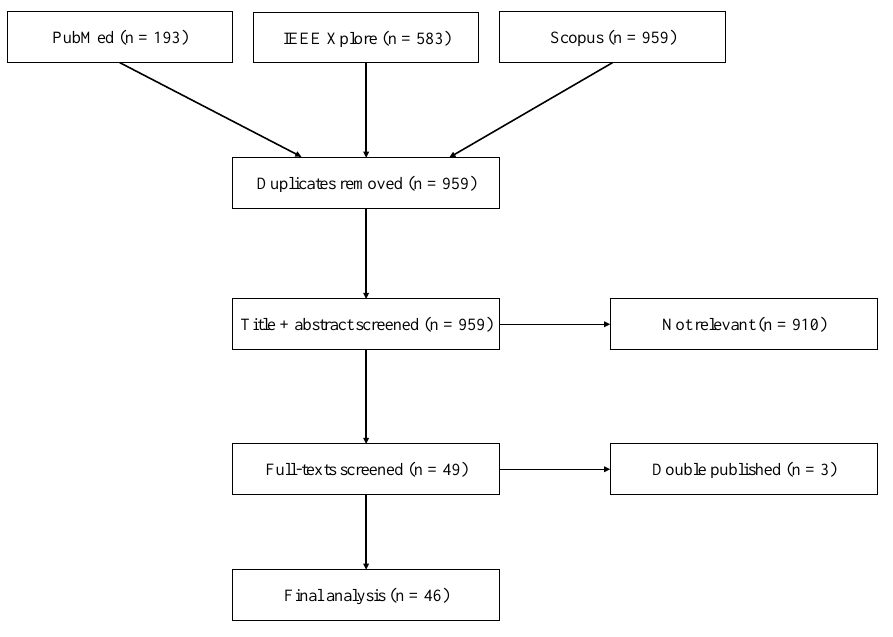
Figure 2. Result of literature review.